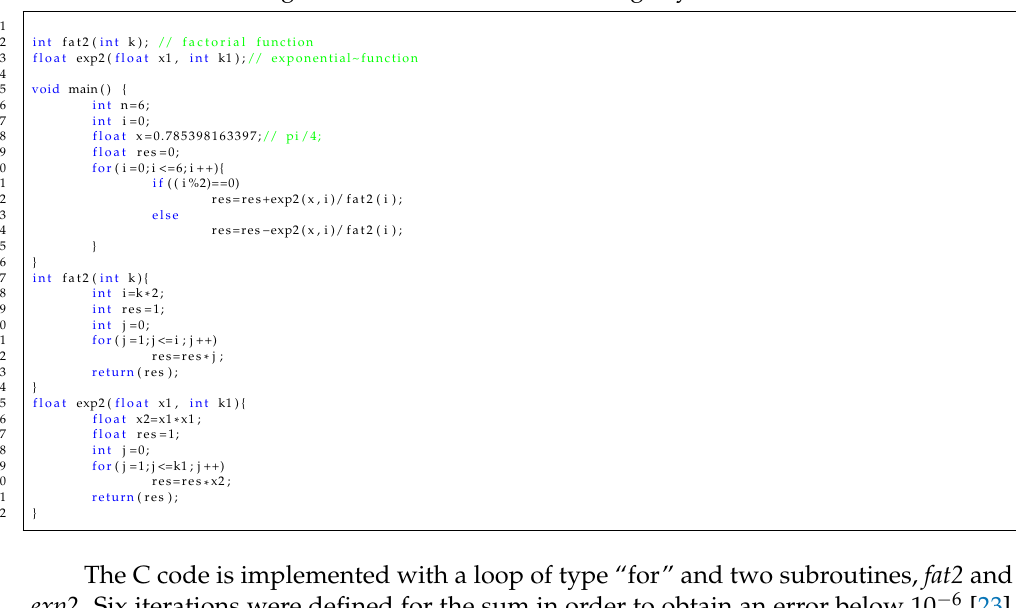
Algorithm 1: Cosine function using Taylor series